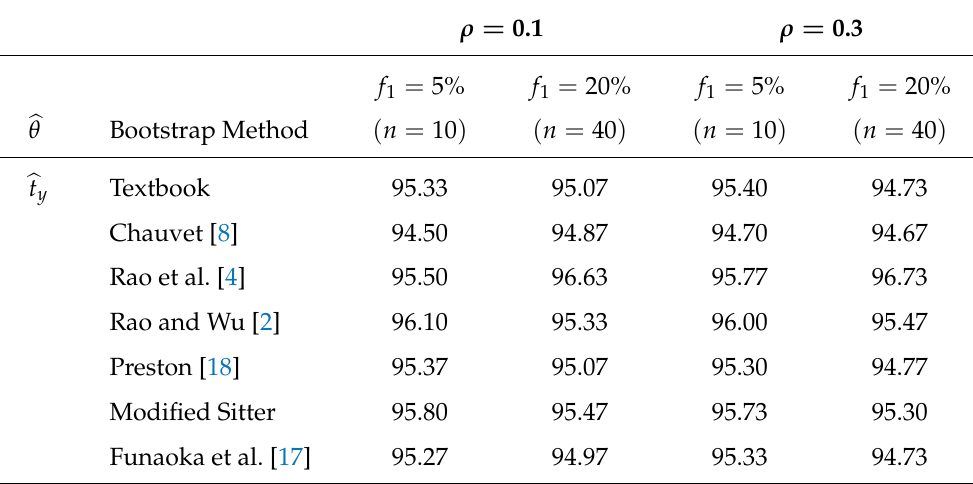
Table 4. Coverage rate (CR) of the 95% t -distribution based confidence intervals constructed using bootstrap standard error estimators based on 3000 samples selected according to